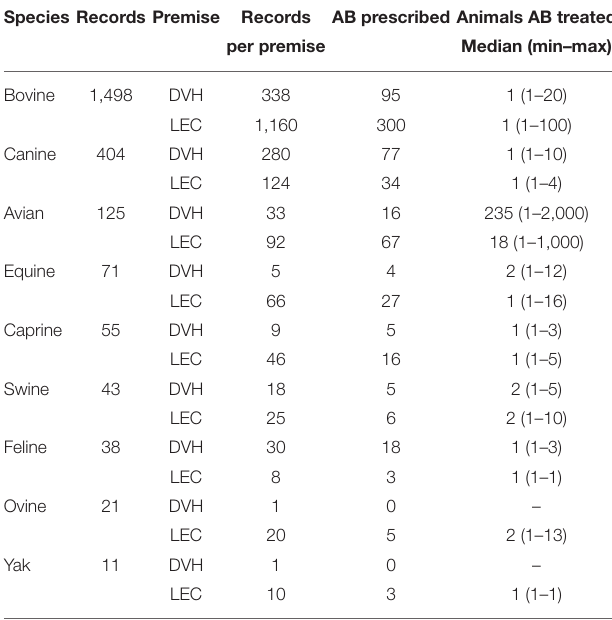
TABLE 1 | Veterinary consultation records ( n = 2,266) obtained from 23 animal health premises in WRLDj (set 3). Species Records Premise Records AB prescribed Animals AB